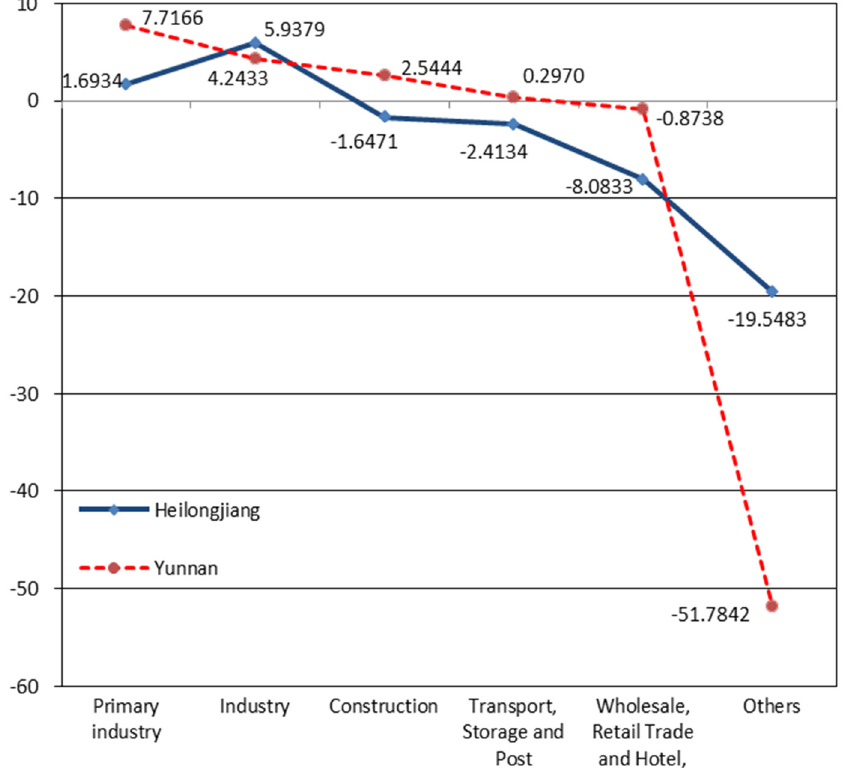
Figure 4. Yunnan and Heilongjiang provinces’ carbon productivity specific contribution